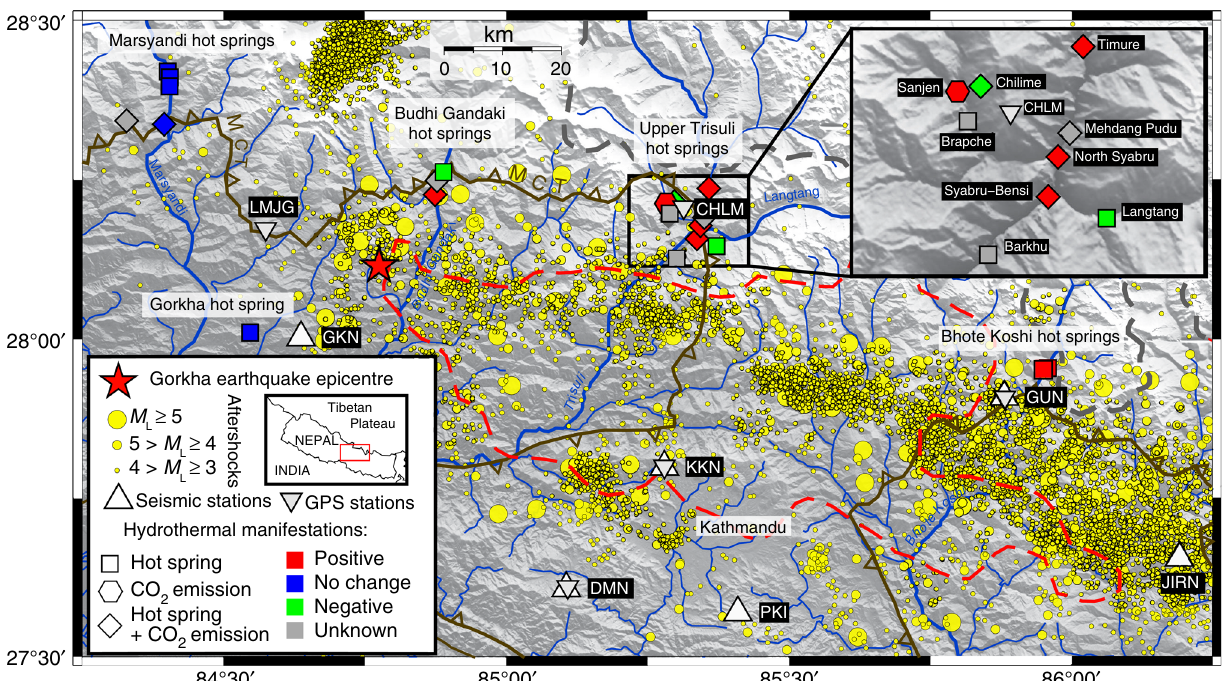
Fig. 1 Post-seismic responses of carbon dioxide emissions and hot springs following the 25 April 2015 Gorkha earthquake in Central Nepal. Post-seismic responses are shown as coloured symbols: positive effect (red), negative effect (green), absence of any signi fi cant change (blue), or when it is unknown (grey). Aftershock epicentres ( M L ≥ 3) from 25 April 2015 to 31 December 2017 (Nepal National Seismological Centre, NSC) are plotted as yellow dots 43 . The Main Central Thrust (MCT) shear zone (in dark grey), which branches at depth on the MHT, separates low-grade Lesser Himalayan Sequence (LHS) and high-grade Greater Himalayan Sequence (GHS) to the north. The red dashed contour shows the area of slip larger than two metres 41 . The bottom left inset shows the location of the main study area. The top right inset depicts an enlargement of the Upper Trisuli valley. Seismic stations belong to the network operated by NSC (Nepal) and DASE (France): Gorkha (GKN), Daman (DMN), Kakani (KKN), Phulchoki (PKI), Gumba (GUN) and Jiri (JIRN). Global Positioning System (GPS) stations belong to the Nepal Geodetic network operated by Caltech (USA), DMG (Nepal) and DASE (France): Lamjung (LMJG), Daman (DMN), Chilime (CHLM), Kakani (KKN) and Gumba (GUN). Details of the main CO 2 emission sites and of the hot spring sites as well as their respective responses to the earthquake are given in Table 1 and Supplementary Table 1 and in Table 2 and Supplementary Table 2, respectively. Figure performed using Generic Mapping Tool